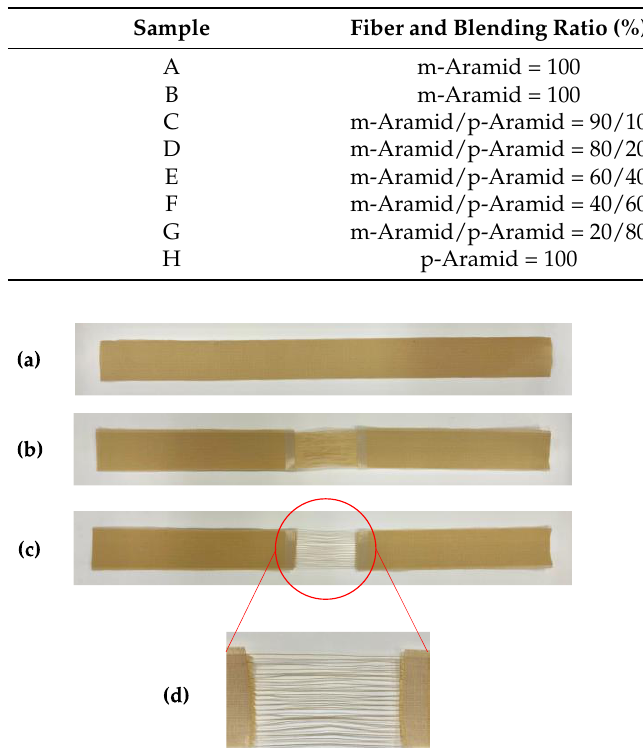
Figure 1. Preparation of yarn samples made from firefighter clothing outer layer fabrics (Sample I). ( a – d ) show the procedure for preparing yarn specimens for UV exposure, respectively: ( a ) a woven fabric for preparing yarn specimens, ( b ) unraveled weft yarn, ( c ) thinning out of warp yarn, and ( d ) enlargement of the red circle in ( c ). 56 mm